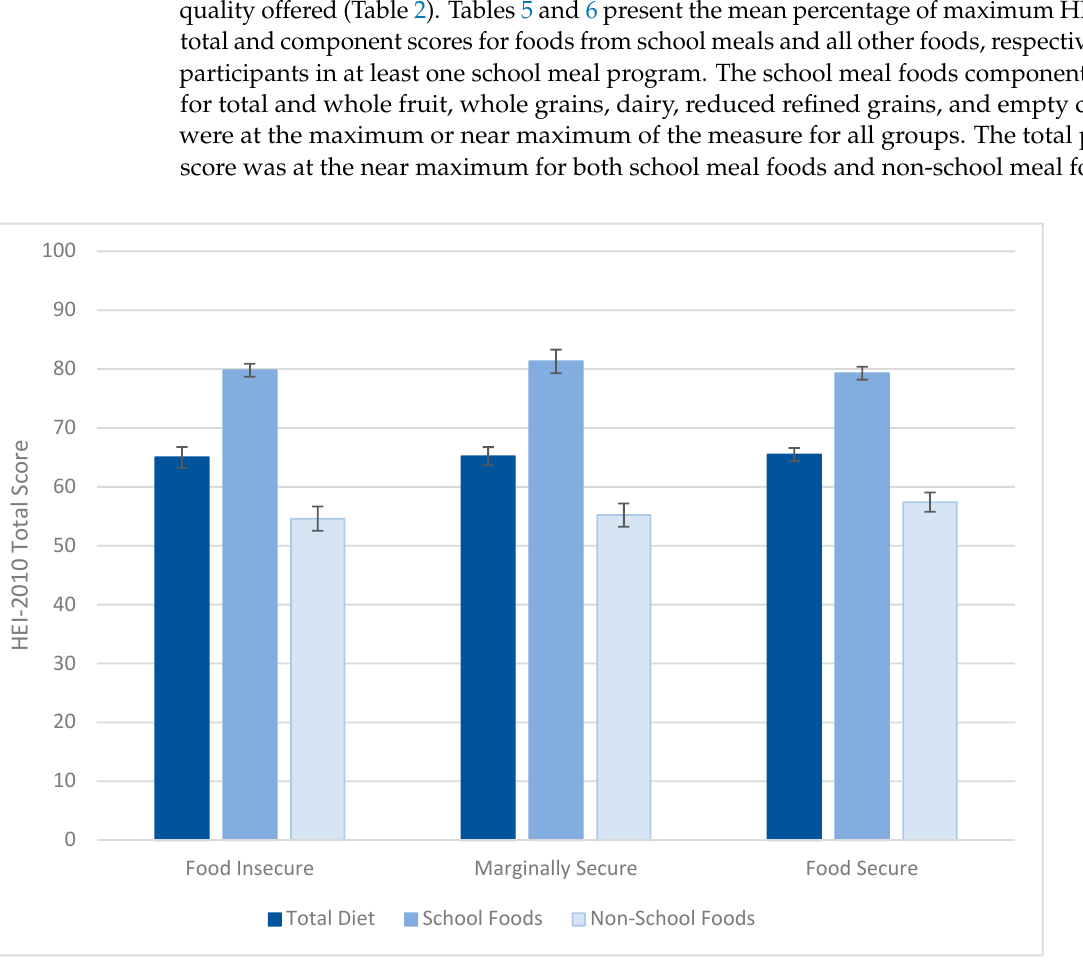
Figure 1. School meal participants’ diet quality (HEI-2010 scores), by food security status. Food security status was based on the adult food security measure. Table 5. HEI-2010 total and component scores, expressed as the mean percentage of the maximum score, for all NSLP and SBP foods consumed by school meal participants, by food security status 1 .